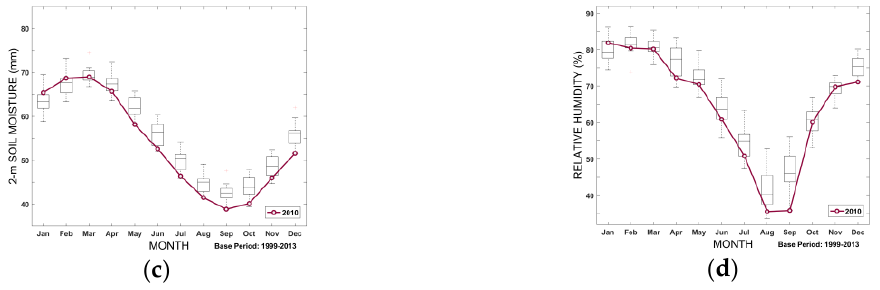
Figure 9 . The same as Figure 7 but for the southeastern region (area 3 in Figure 1) and for 2010 (red curve). The SRDAS precipitation (2-m temperature above ground) values are averaged over an entire region what might explain the lower (higher) values of precipitation (2-m temperature above ground) in comparison with the observed values at station sites.